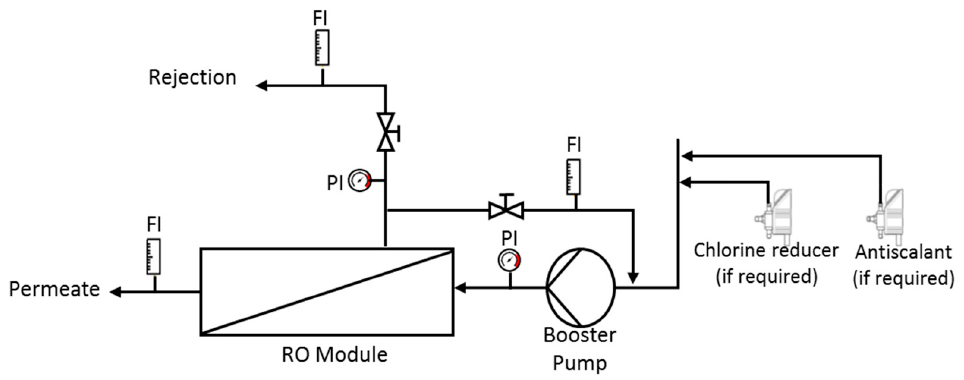
Figure 2. RO pilot plant scheme (Source: Bioazul S.L.).